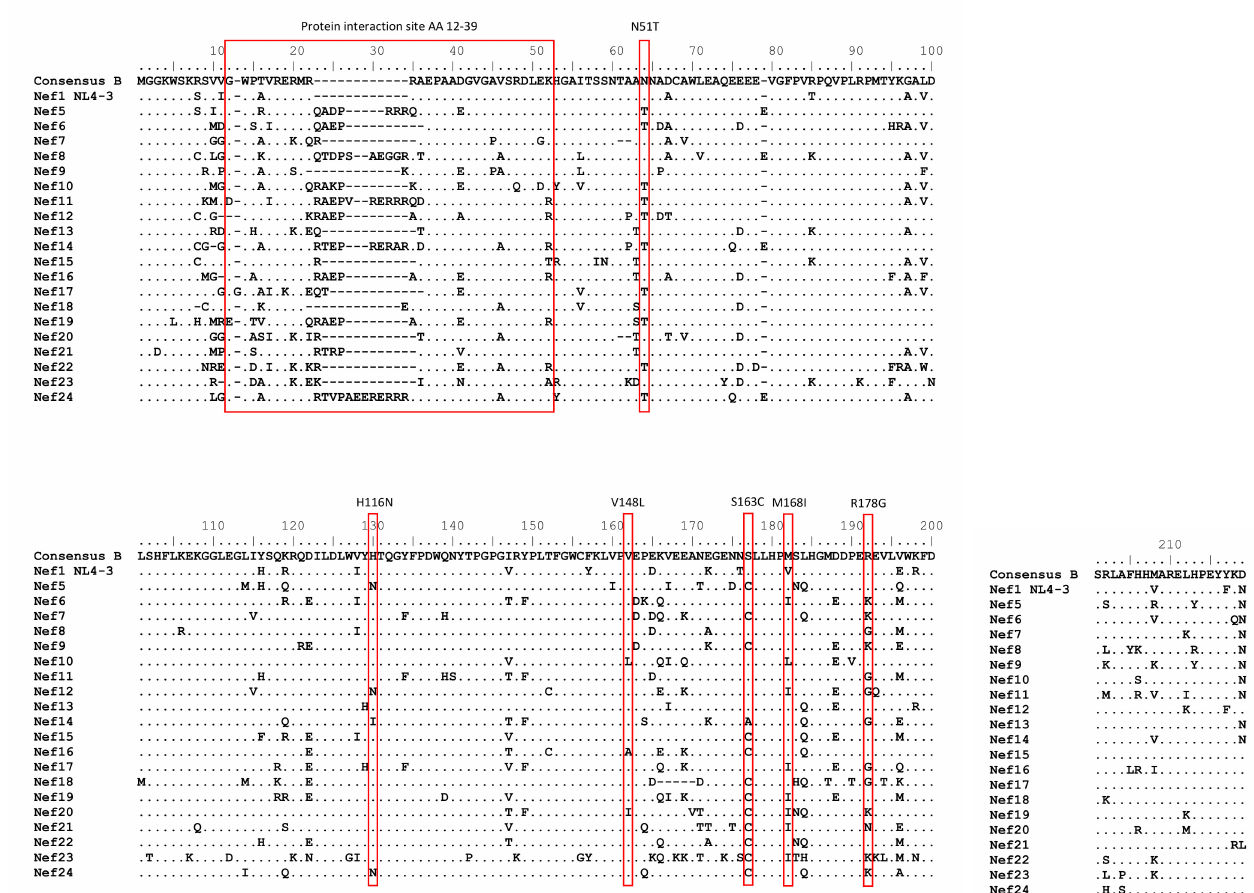
Figure 3. Amino acid variation in Nef proteins obtained from individuals with HIV-1. HIV-1 consensus B Nef, NL4-3 Nef (Nef1) and Nef proteins from patients with HIV-1 (Nef5-24). Red boxes indicate some of the previously described amino acid polymorphisms [14,25,26] and binding sites for